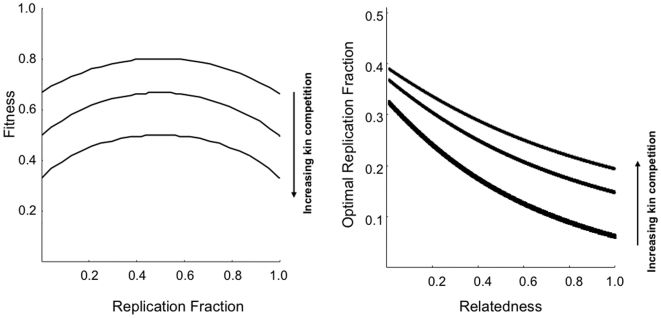

The role of parasite replication and relatedness on fitness.
(A) Parasite fitness is a non-linear function of replication fraction (ρih) and declines with increasing kin competition (α). (B) The optimal replication fraction declines with increasing levels of relatedness (R) within a host as prudent exploitation strategies predominant and increases with increasing kin competition (Other parameters η = 1, c = 0.5,  = 0.5).